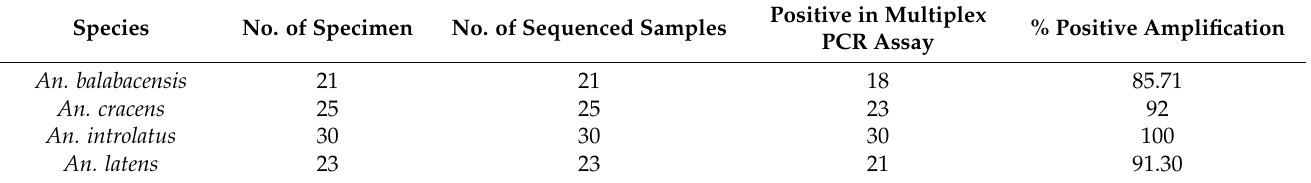
Table 2. Results from multiplex PCR on sequenced samples of Leucosphyrus Group of